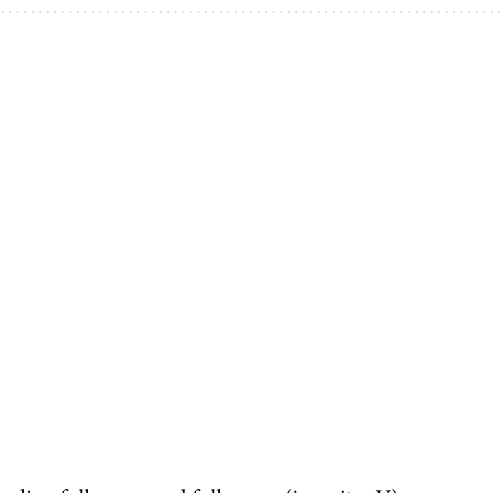
Figure 10. As shown in the figure, by calculating the total energy of particles, in singlet and triplet states at their optimized and ground states geometries, the optical gap gaps can be calculated.